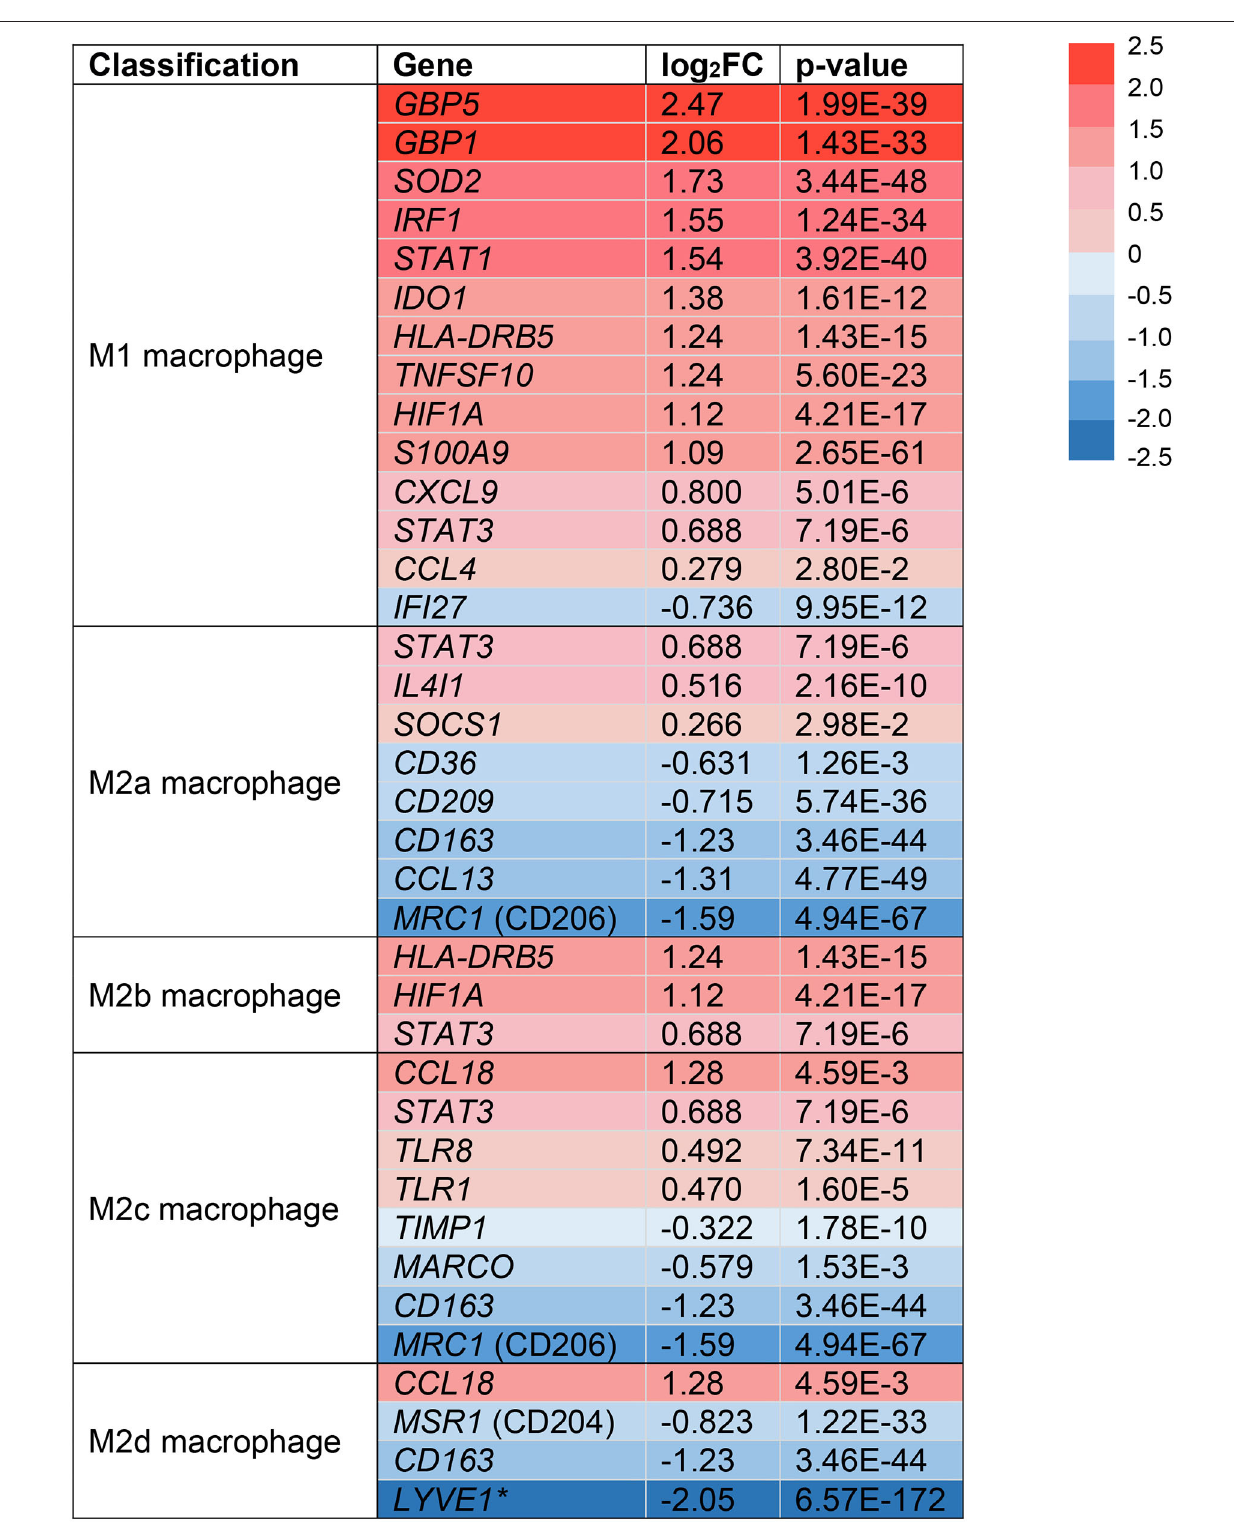
Frontiers in Medicine |